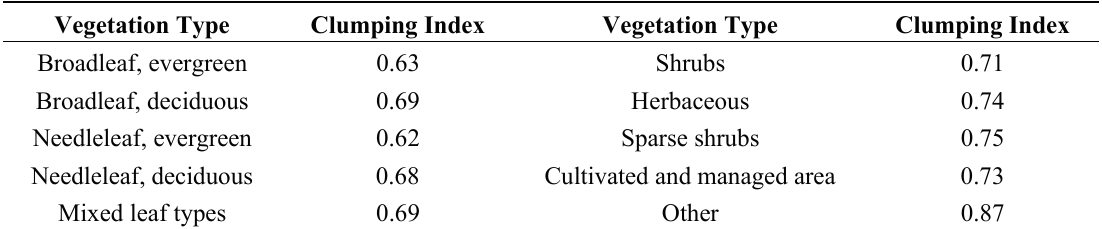
Table 1. Clumping indices for different vegetation types.